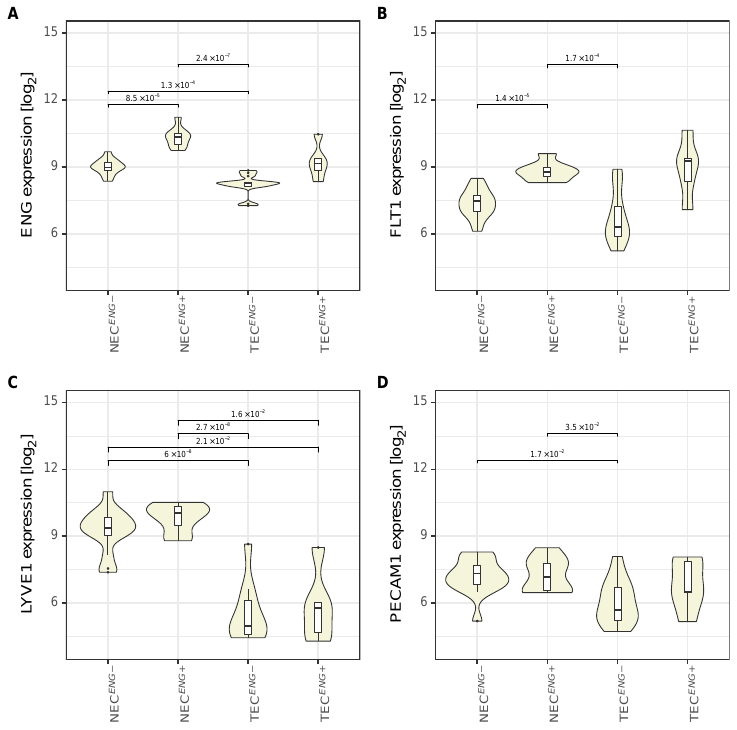
Figure 2. Expression of ENG , FLT1 , LYVE1 , and PECAM1 in TEC and NEC ( ENG − and ENG + ). Violin plots of the expression distribution of ( A ) ENG , ( B ) FLT1 , ( C ) LYVE1 , and ( D ) PECAM1 are shown. Numbers above the bars represent adjusted p -values of the comparisons indicated by the bar.